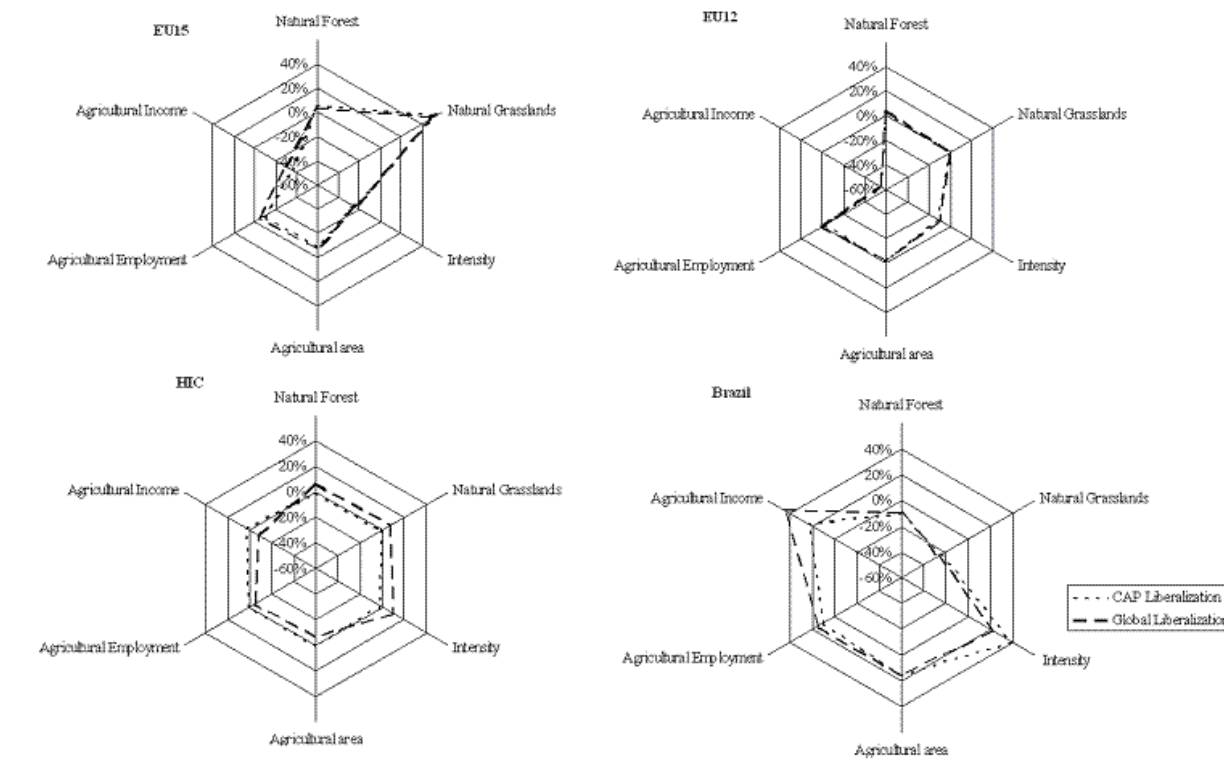
Fig. 5 . Trade-offs between environmental indicators, i.e., natural forest, natural grassland, and intensity of agricultural management, and socioeconomic indicators, i.e., agricultural income and agricultural employment in EU15, EU12, High Income Countries (HIC), and Brazil in the Common Agricultural Policies (CAP) Liberalization option and the Global Liberalization option compared to the